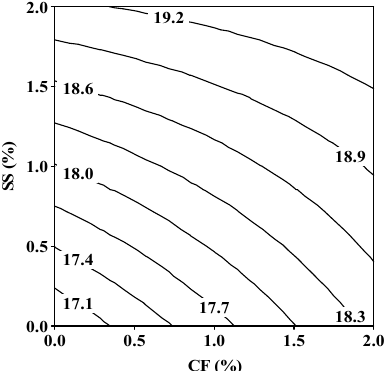
Figure 3. Effect of CF and SS on the 1 d strength of cement mortars.